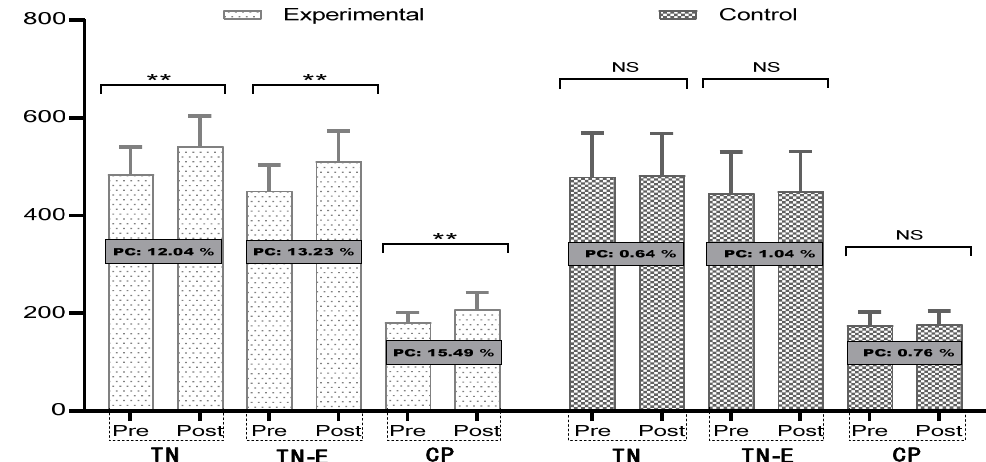
Figure 3. The comparison of the pretest and posttest attention scores within groups and percentage change. ** p < 0.001, NS: non-significant, Pre: pre-test, Post: posttest, TN: total number of marked items, TN-E: total item number − total error, CP: concentration performance, number of correctly marked items, PC: Percentage changes pre and pos tt est.